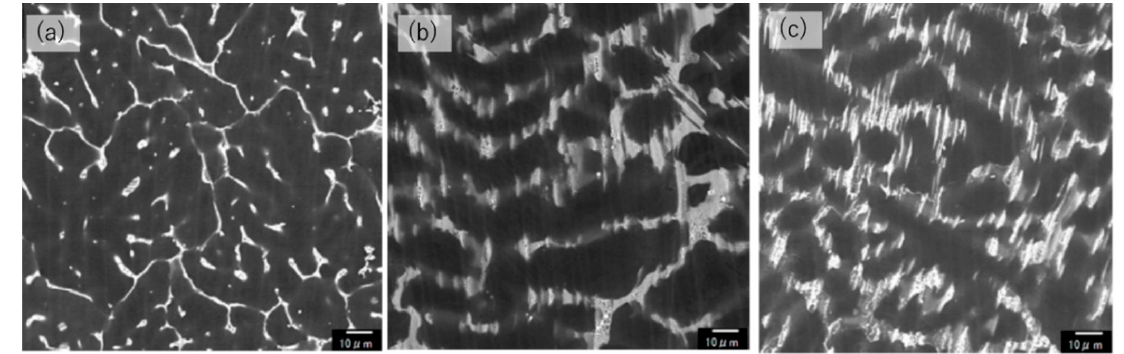
Figure 4. ( a ) Backscattered electron mode of scanning electron microscopy of the Mg 97 Zn 1 Y 2 alloy, which had been recovered after being annealed at 3 GPa and 823 K for 2 h, and subsequently annealed for 10 min at ( a ) 623 K, ( b ) 643 K, ( c ) 723 K, respectively.